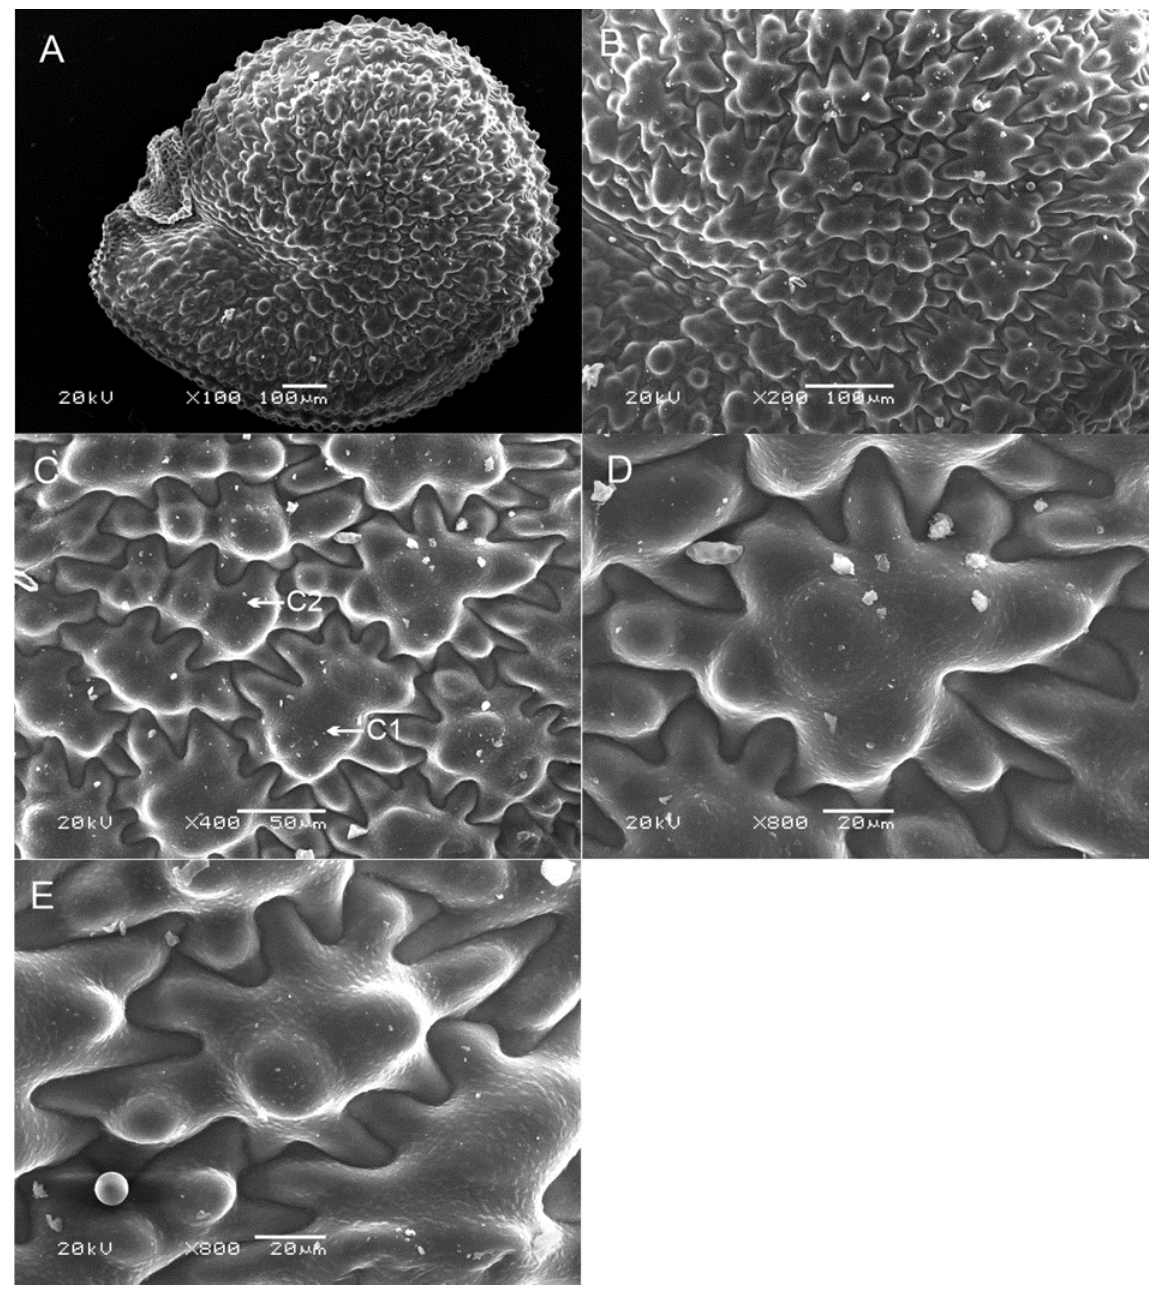
Figure 4 Portulaca macrantha (SEM). General view of the seed ( A ). e seed surface ( B,C ). Isodiametric cell ( C1 ), elongated cell ( C2 ); general view of the cells ( D,E